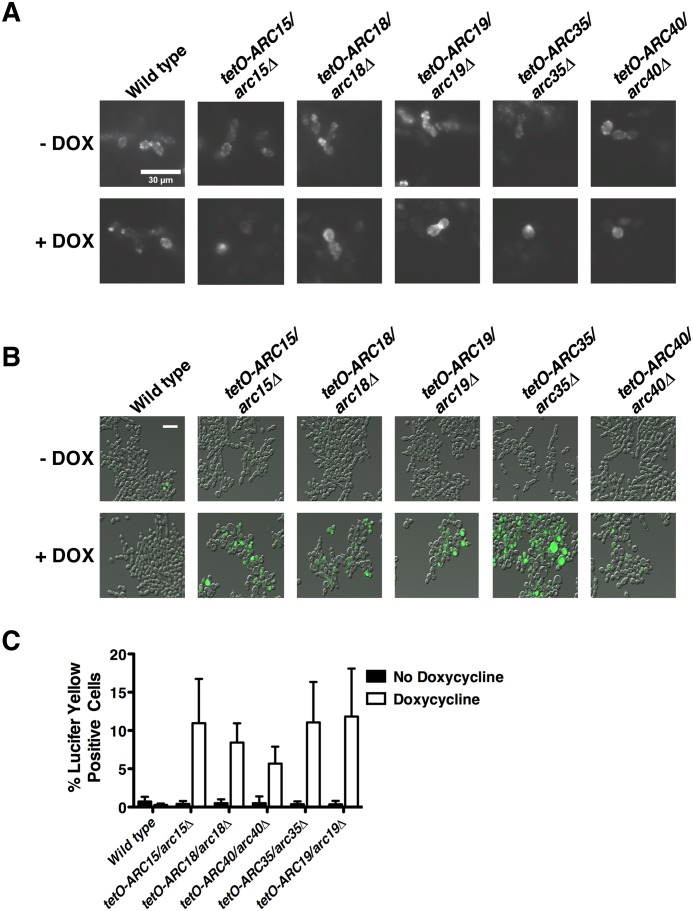
Transcriptional repression of components of the Apr2/3 complex leads to impaired actin patch formation and enhanced rates of endocytosis.(A) Microscopy images of Arp2/3 complex mutants grown in the absence or presence of doxycycline and then stained with Rhodamine-Phalloidin. (B) Microscopy images of Arp2/3 complex mutants grown in the absence or presence of doxycycline and then incubated with Lucifer Yellow. Scale bar represents 30 μm. (C) Quantification of endocytosis defect by counting the number of cells staining positive for Lucifer Yellow. Error bars represent standard deviations of nine technical measurements. Depletion of each component of the Arp2/3 complex significantly increases the rate of endocytosis (P<0.01, ANOVA, Bonferroni's Multiple Comparison Test).